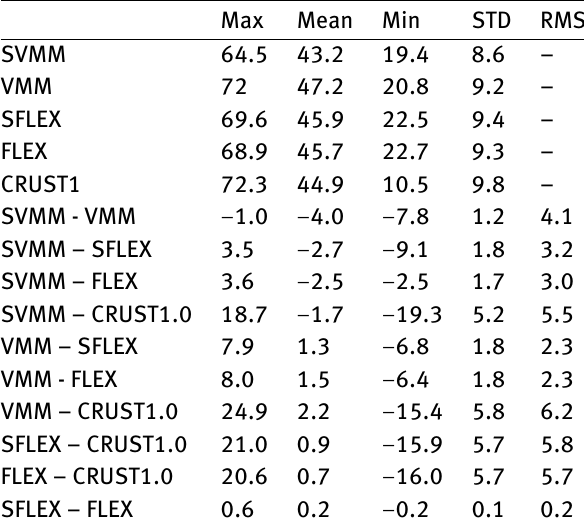
Table 1: Statistics of different Moho models and their differences [km]